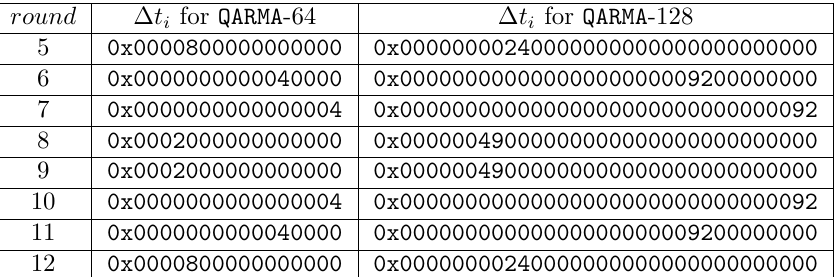
Table 10: Difference of Round Tweak for No. 5 Distinguisher